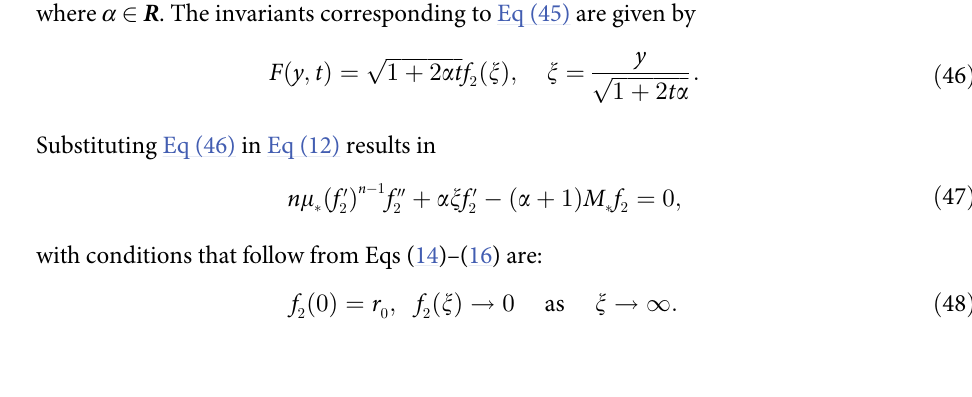
Fig 4. Velocity profile for various values of φ and M when ρ are fixed.